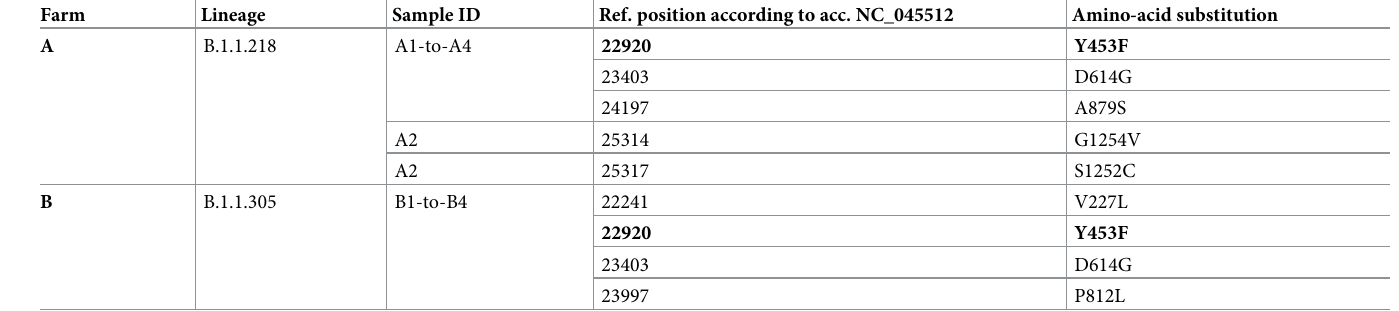
Table 1. List of SARS-CoV-2 S protein amino-acid substitutions detected in sequenced samples from farm A and farm B. The mink-specific substitution (Y453F) is shown in bold. Lineages have been assigned with the PANGOLIN interface.